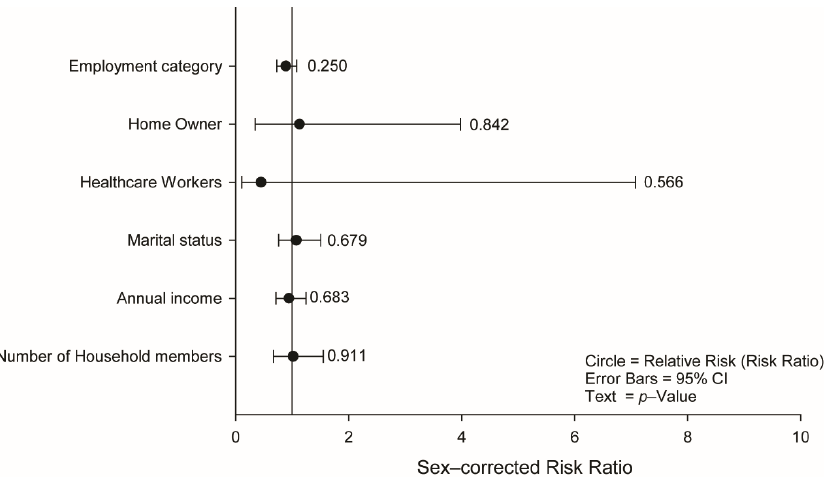
Figure 4. Socioeconomic covariates do not determine SARS-CoV-2 IgA seropositivity in asymptomatic or oligosymptomatic individuals. Sex-adjusted logistic regression relative risk of SARS-CoV-2 IgA seropositive due to current socioeconomic conditions. Circles represent the relative risk (RR); error bars: 95% confidence interval; text: p -value.